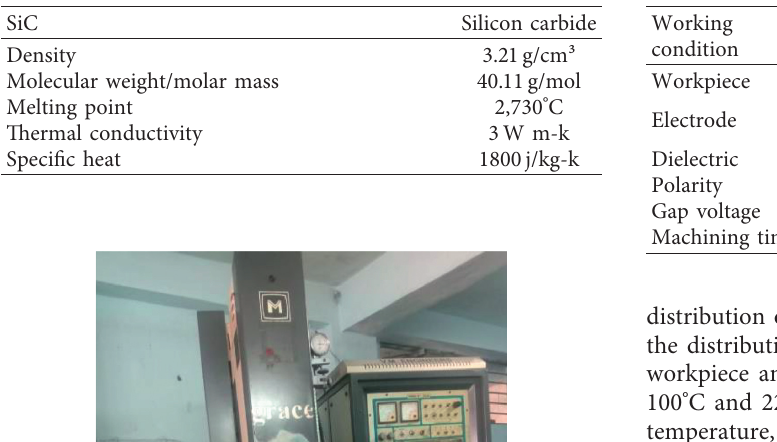
Table 3: Chemical composition of SiC.